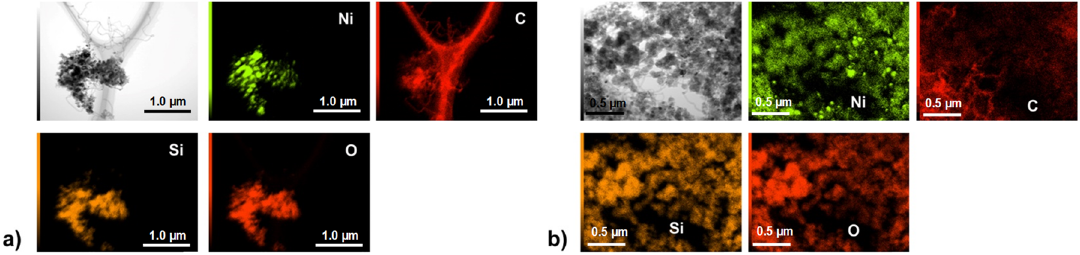
Figure 10. STEM-EDS elemental mapping images of catalysts after stability test at 850 °C: ( a ) Ni/SiO 2 , and ( b ) Ni-C/SiO 2 .